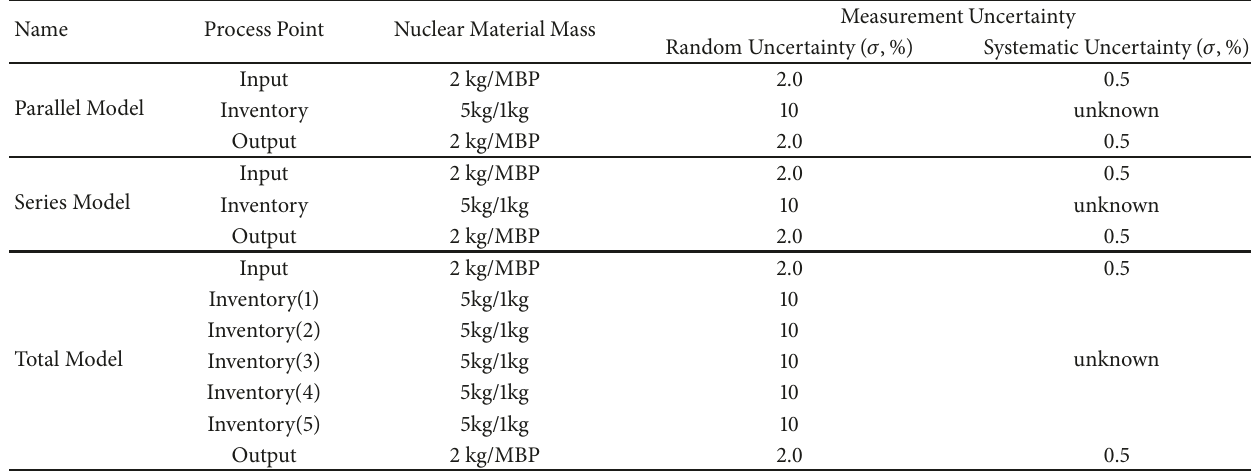
Table 1: Process and measurement models in intercomparative study (1).